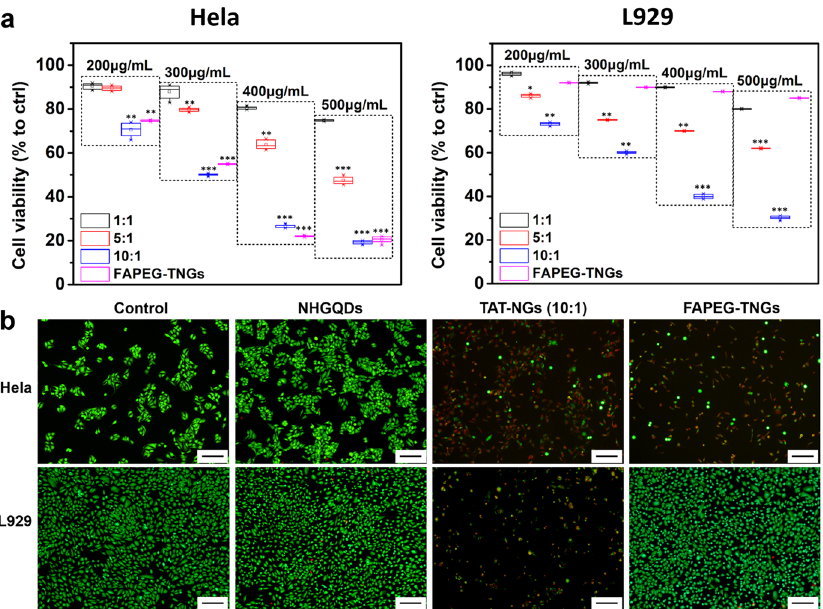
Fig. 6 Cell viability of HeLa or L929 cells treated with TAT-NGs and FAPEG-TNGs for 24 h. a CCK-8 assay. b Live/dead staining of cells by Calcein-AM/ PI. Scale bars, 100 μ